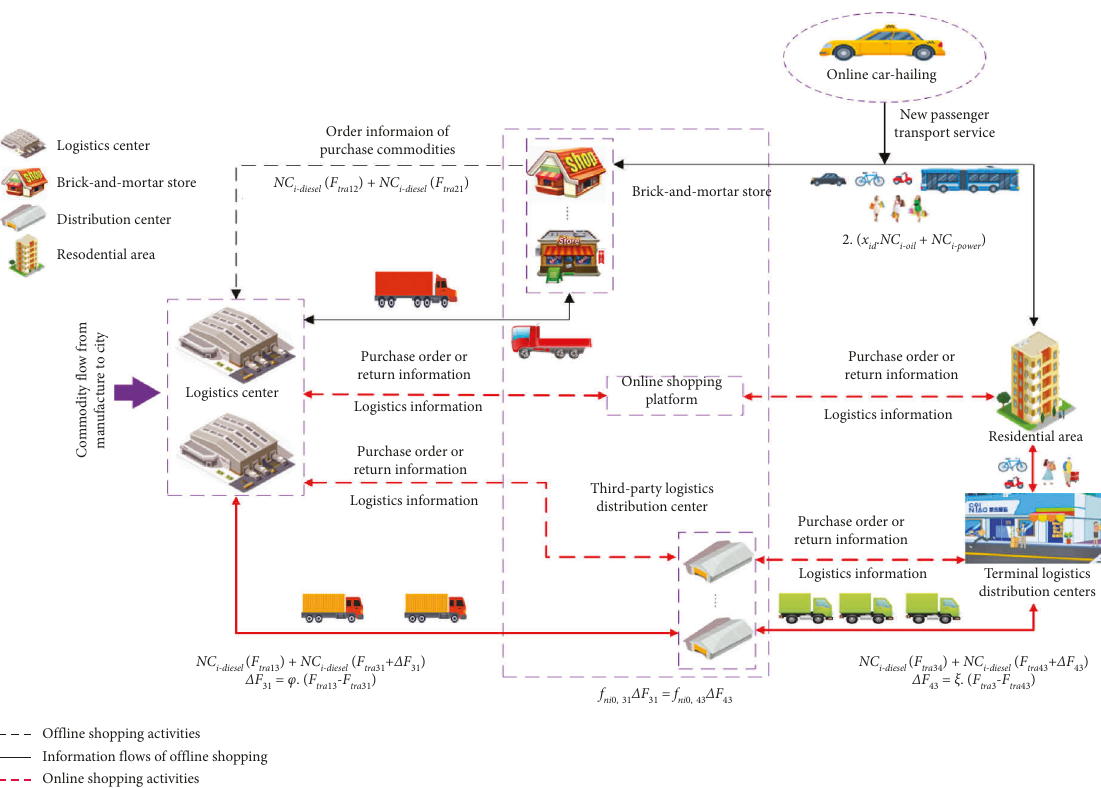
Figure 4: Retail commodity distribution network in